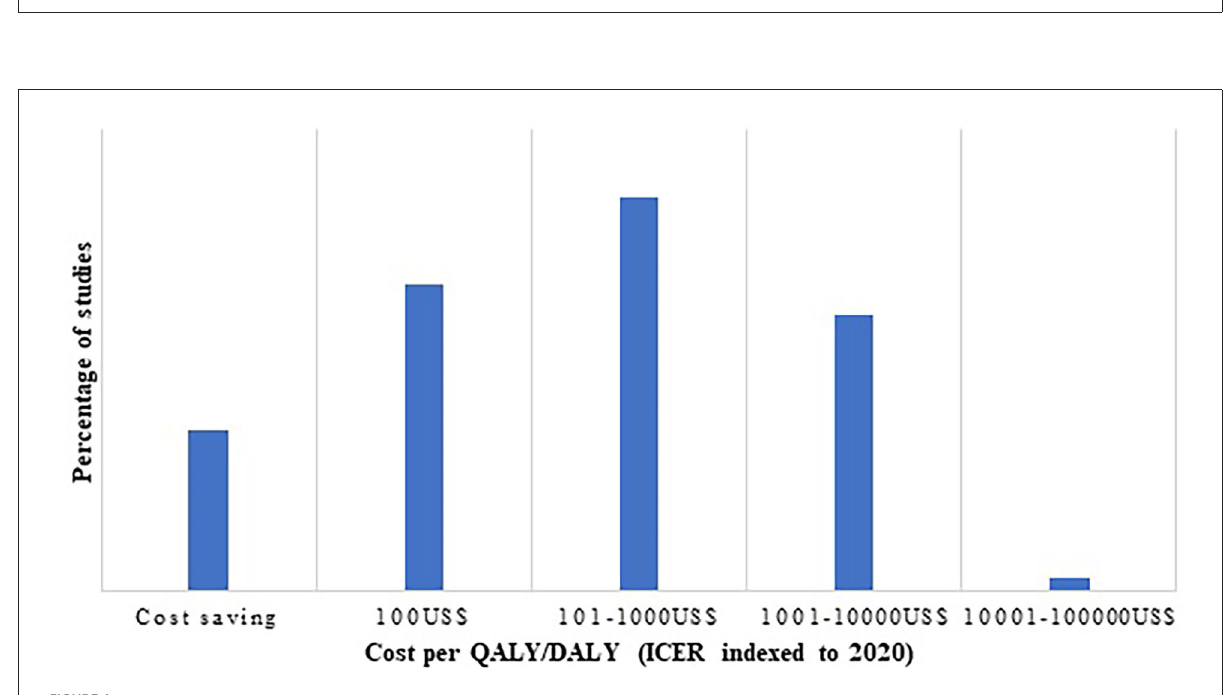
FIGURE4 Number of studies classified as cost per QALY/DALY